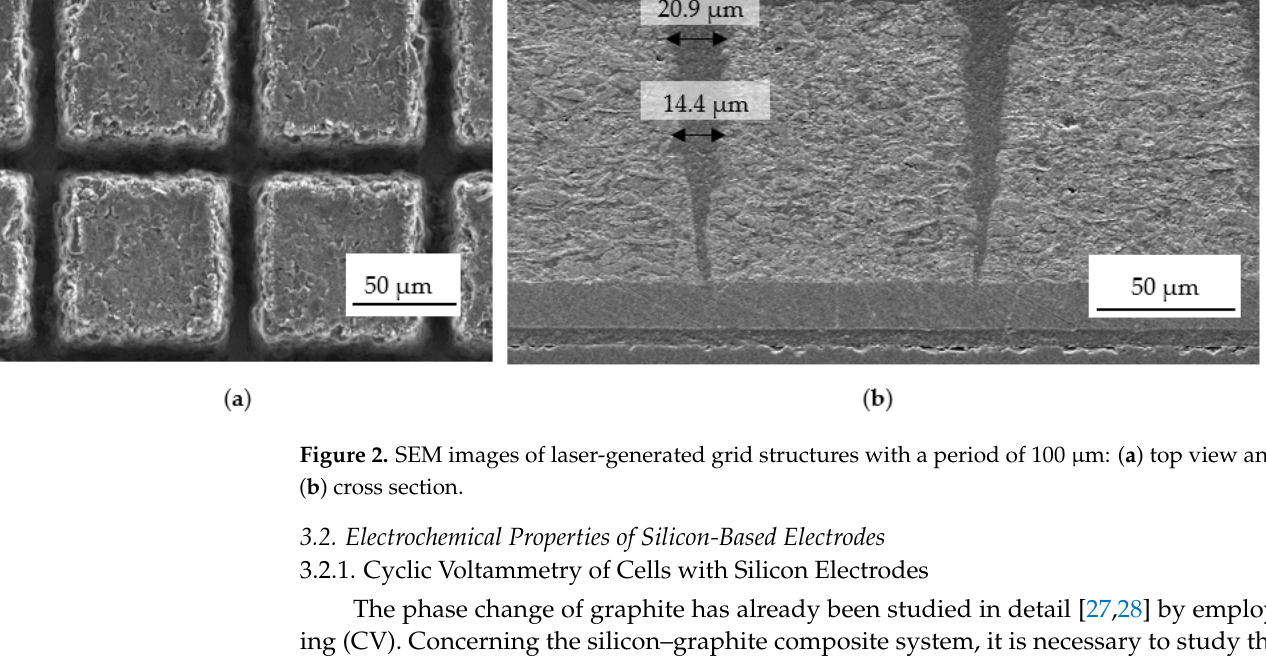
Figure 1. Scanning electron microscopy (SEM) image of a laser-generated model electrode with mi- cropillar structures (800 µm × 800 µm).